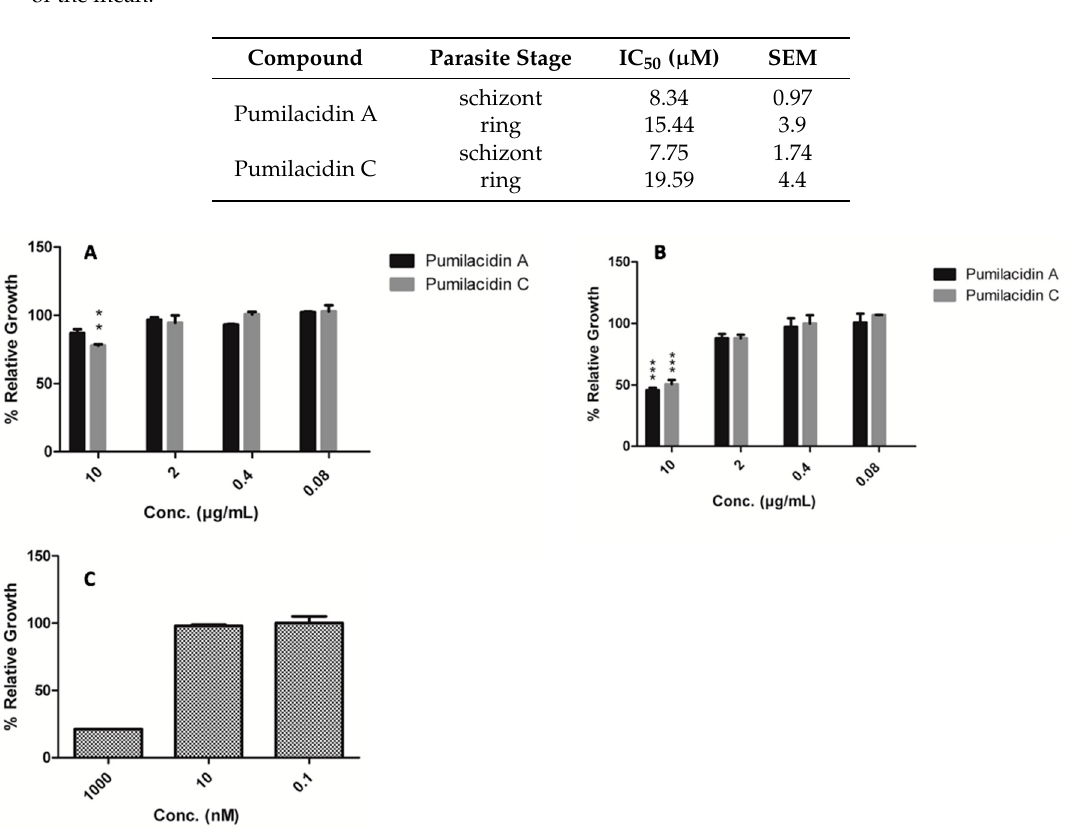
Figure 2. Effect of pumilacidins on the proliferation of Plasmodium falciparum . ( A ) Ring stage; ( B ) schizont stage; ( C ) chloroquine (CQ) control in ring stage. Plasmodium parasites were incubated together with pumilacidins A and C at 10, 2, 0.4, and 0.08 μ M, and CQ at 1000, 10, and 0.1 nM for 48 h. The proliferation of pumilacidin-treated parasites was measured by PicoGreen DNA fluorometric measurement. Data represent the means ± standard error of the mean (SEM) of one representative observation out of three experiments performed in duplicate. ** p < 0.01, *** p <